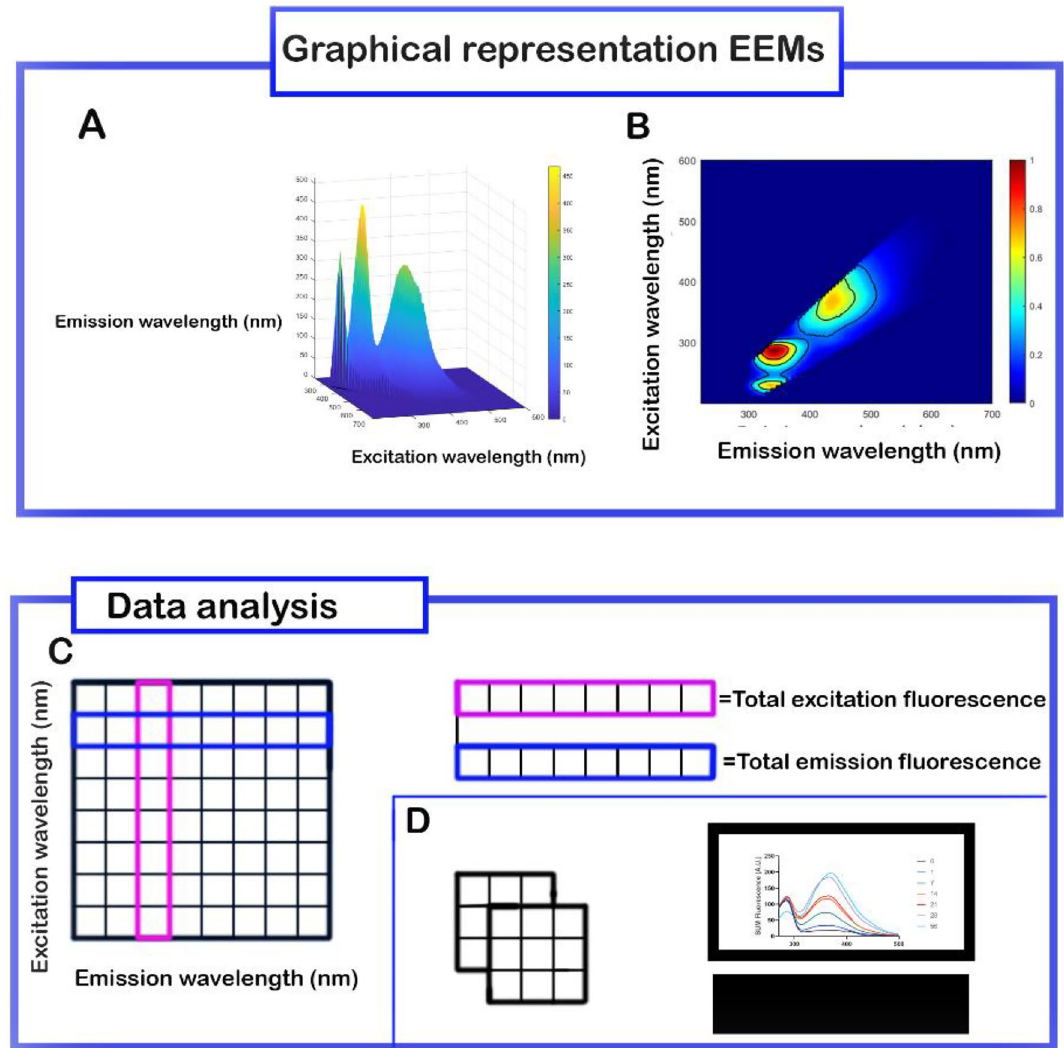
Figure 5. Schematic overview of data analysis to produce the body fluid signatures. ( A ) 3D view of excitation and emission map (EEMs) of a 2 weeks old semen stain. ( B ) 2D view of corrected and normalized EEMs of two weeks old semen stain. ( C ) Compute the summed fluorescence of all excitation wavelengths for each emission wavelength (pink). Compute the summed fluorescence of all emission wavelengths for each excitation wavelength (blue). ( D ) Repeat procedure for each excitation and emission wavelength for every donor on every time point, and plot the average fluorences of all donors for each time point showing the bodyfluid specific fluorescent